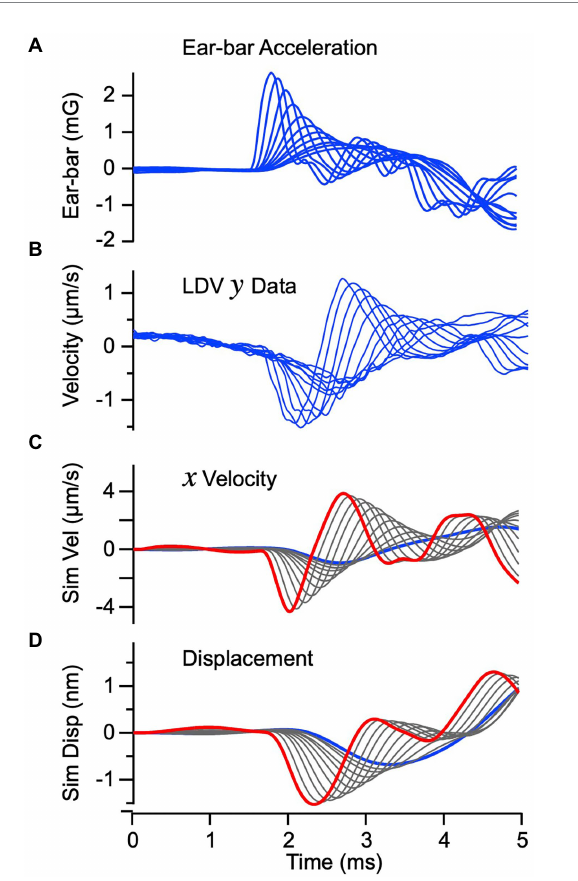
FIGURE 3 Vibration of the macula for BCV: Theory vs. Experiment. (A) Input acceleration of the ear-bar fixture “ a ” measured experimentally in the guinea pig (blue). Individual curves show responses for different voltage magnitudes and rise-times driving the vibrational stimulator. (B) Velocity of the epithelium measured by LDV in the “ y ” direction. (C) Simulated velocity of the epithelium in the “ x ” direction in response to temporal bone acceleration. The simulated velocity (C) closely follows the macula velocity measured in the “ y ” direction when scaled by the geometrical fator 0.3 α≈ . (D) Simulated displacement of the sensory epithelium in the tangential “ x ”